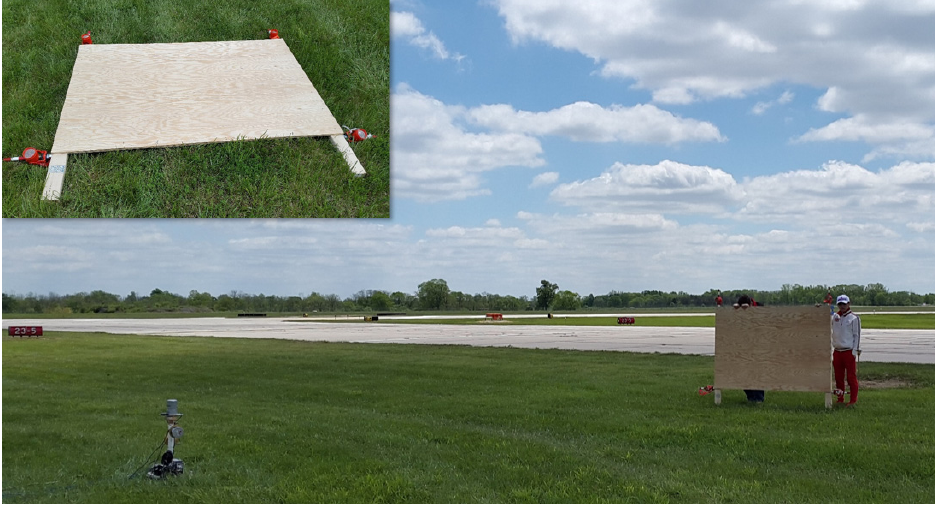
Figure 2. Sensor georeferencing: Calibration board with surveying prism (upper left corner) measured with total station and sensor station.